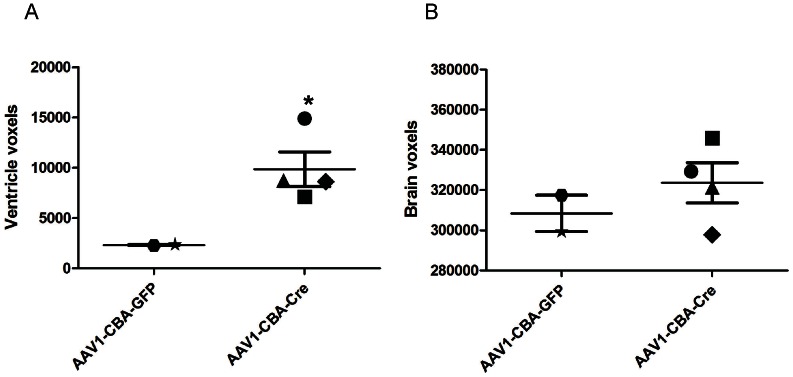
Quantitative volumetric analysis of MR images of Tsc1c/c pups at 1 month of age after P0 ICV injection.Injection of AAV1-CBA-Cre (N = 4) or AAV1-CBA-GFP (N = 2) 2×1010 g.c. per 2 µl into each ventricle was carried out on P0 and MR images were evaluated on P30. (A) Measurement of ventricle size in voxels (each voxel = 0.0976×0.130×1.302 mm).Difference between groups is significant (p<0.044). (B) Measurement of brain parenchyma (excluding ventricle volume) in voxels. Difference between groups, p<0.23, not significant. Measurements were made by observer blinded to genotype.